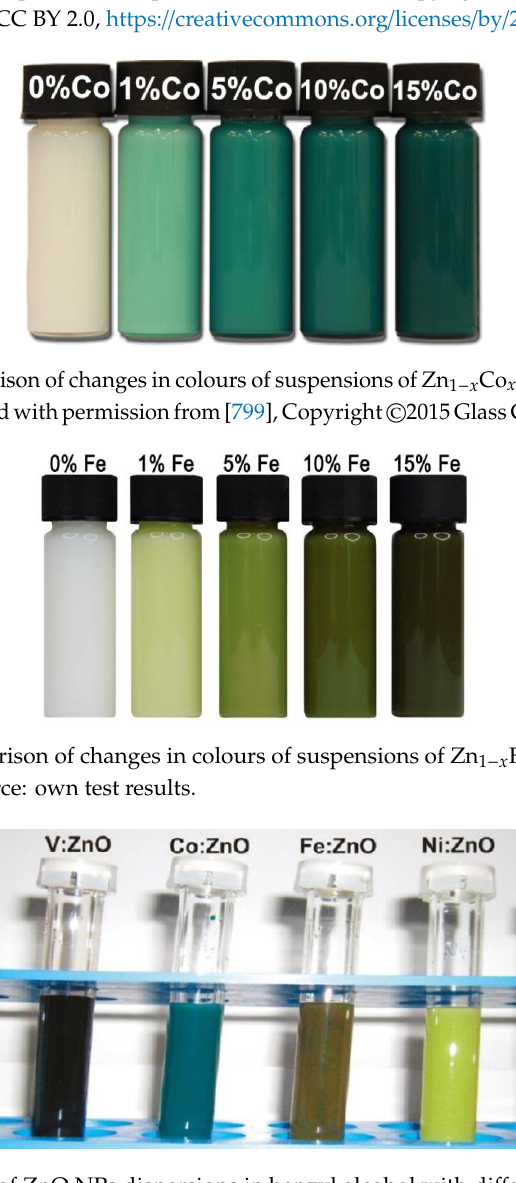
Figure 43. Visual comparison of changes in colours of suspensions of Zn 1− x Mn x O NPs depending on the dopant content. Reprinted with permission from [802]. Copyright © 2016 Wojnarowicz et al.